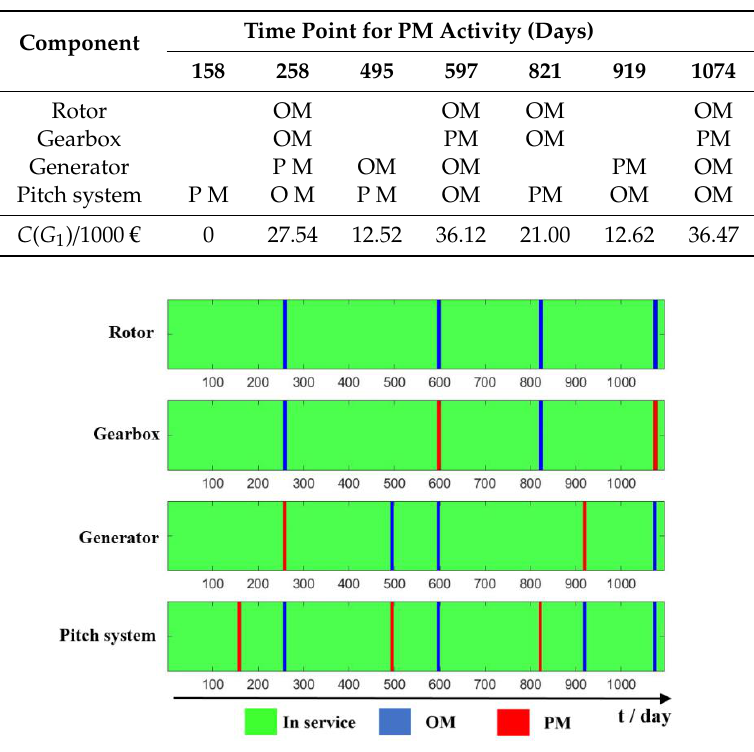
Figure 5. Schematic diagram of cross-validation grouping.